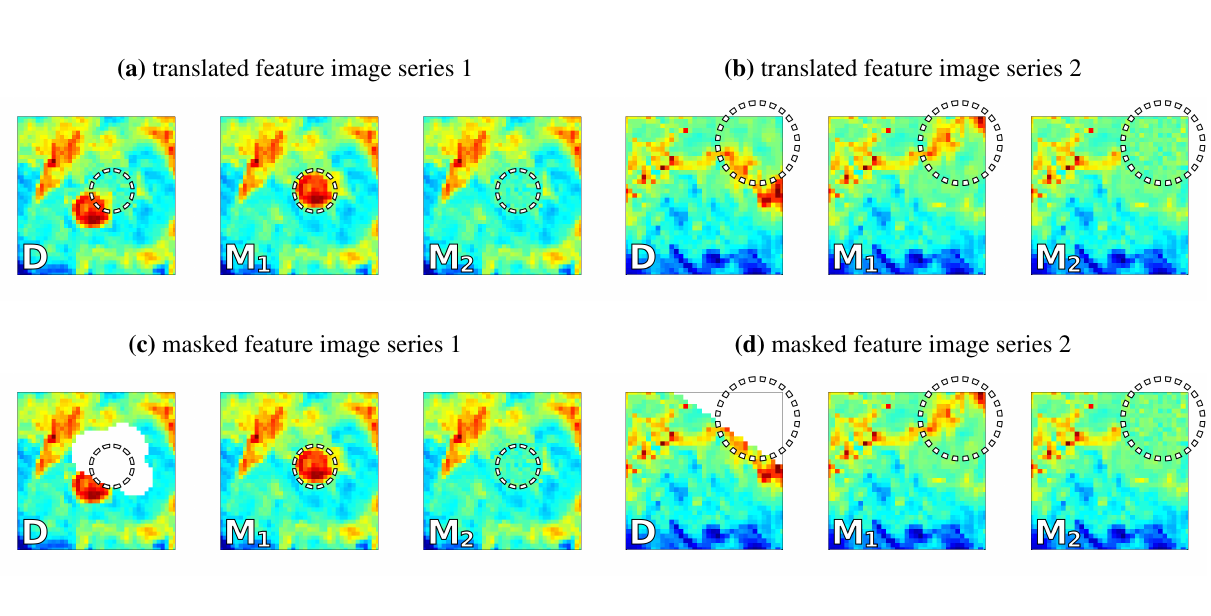
Figure 3. Examples of the manually created images used for the translated and the masked feature tests. In each test case, the first image represents the satellite image D which is compared to the images M (center image) and M (right image). D and M share a common 1 2 1 feature that does not appear in M . The location of this feature in M is highlighted by a 2 1 white dotted circle in every image. In the masked feature tests (c) and (d), this location is masked by NaN -values in D